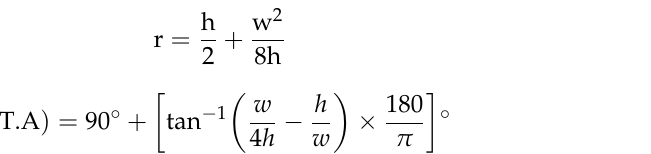
Figure 27. Weld bead shape of the SAW two-run method.